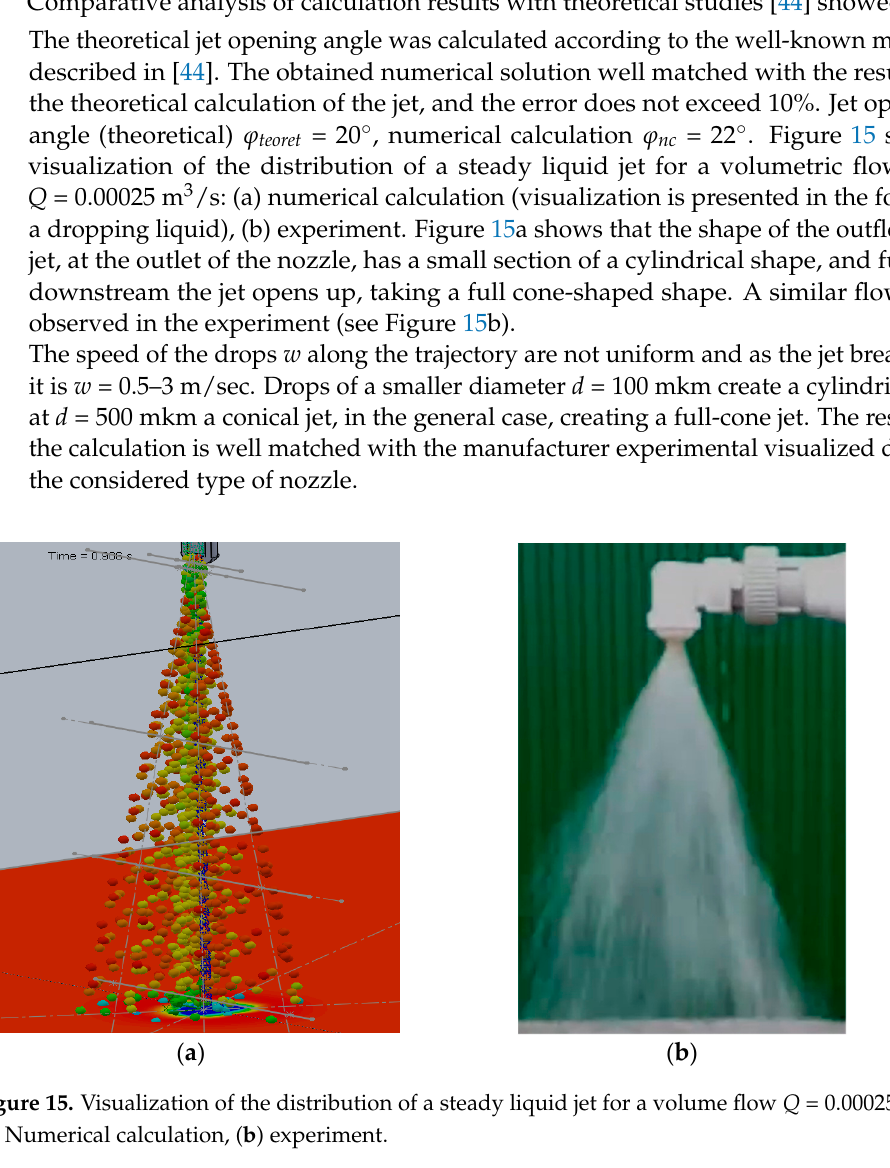
Figure 16. Testing setup in laboratory conditions.